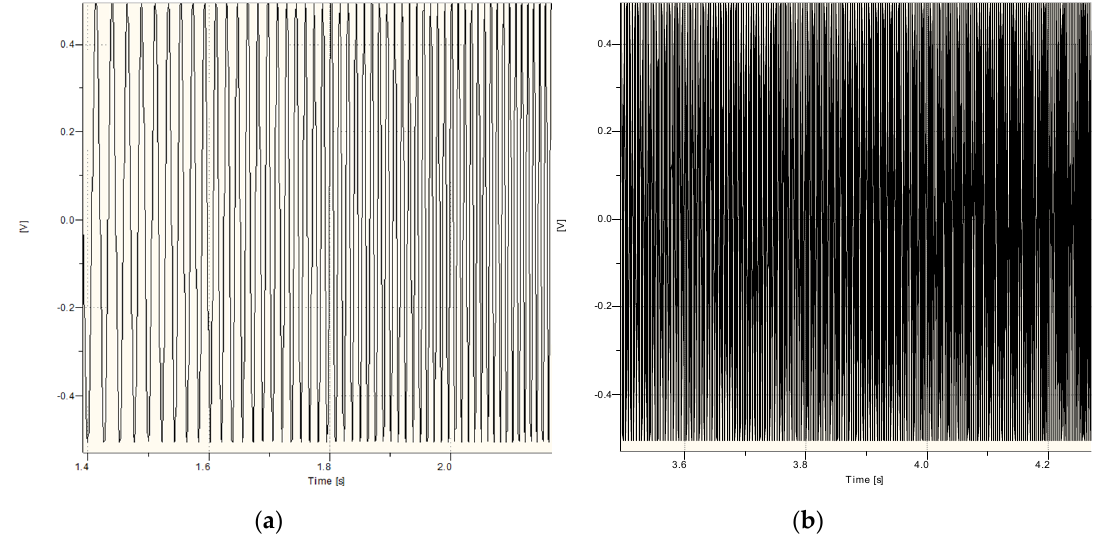
Figure 3. Time courses of sine sweep, 30–300 Hz range: beginning of the signal ( a ), end of the signal ( b ).